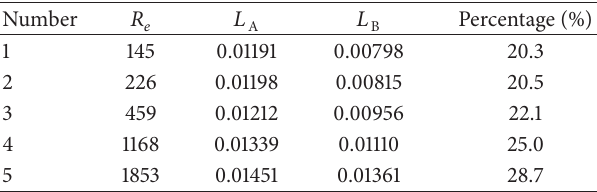
Figure 11: The relationship diagram of 𝑅 𝑒 and length of and 𝐿 . A B